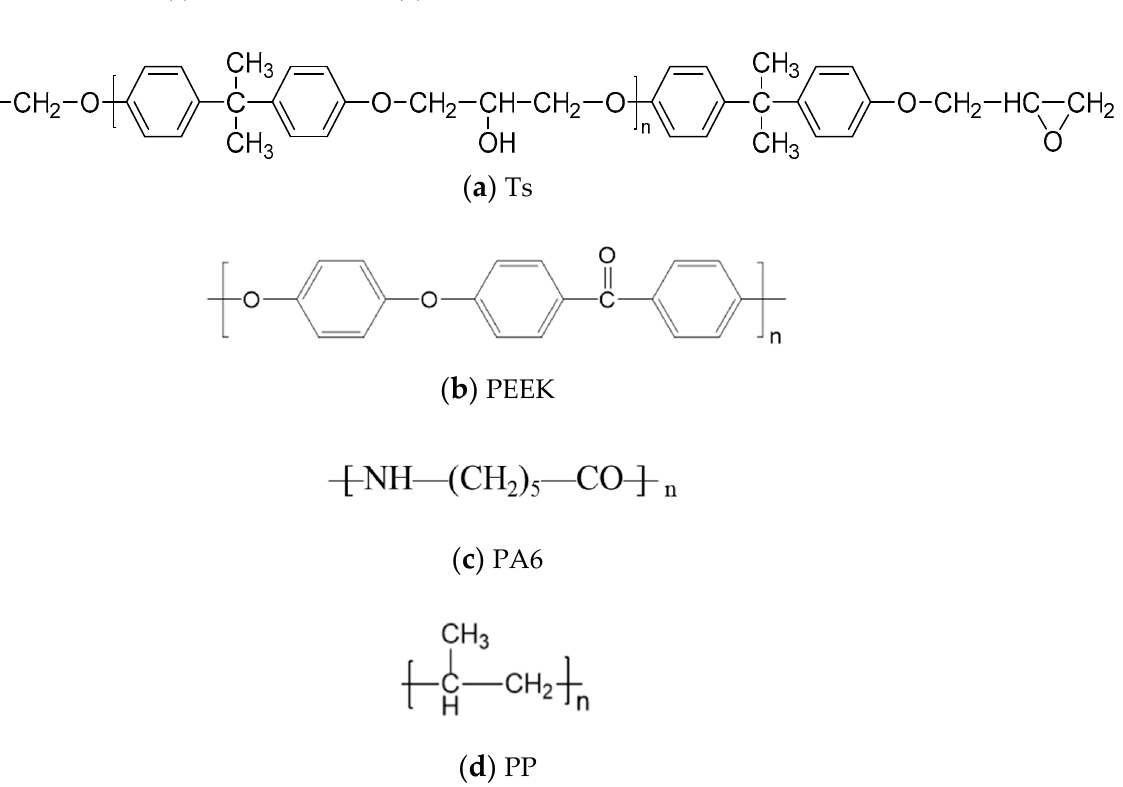
Figure 15. Effects of thermoplastic composite fillers on infrared transmission of Ts resin of ( a ) 400–4000 cm − 1 and ( b ) 1500–2000 cm − 1 .